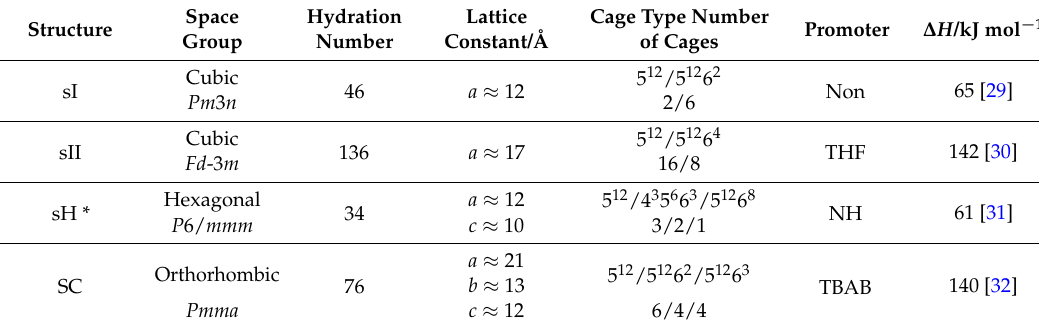
Figure 1. Host structure of a semi-clathrate hydrate (SC) and gas hydrate. ( a ) Schematic representation of orthorhombic SC; and ( b ) polyhedral host cages in SC: 5 12 cage (dark gray), 5 12 6 2 and 5 12 6 3 cages occupied by a tetra- n -butylammonium (TBA) cation; ( c ) Schematic representation of sI hydrate; and ( d ) polyhedral host cages in sI hydrate: 5 12 cage (dark gray) and 5 12 6 2 cage (light gray). Table 1. Crystallographic data of four types of clathrate hydrates.